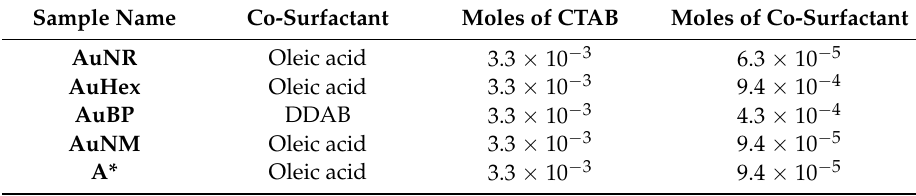
Table 2. Moles of surfactant and co-surfactant used for synthesis of AuNPs. Sample